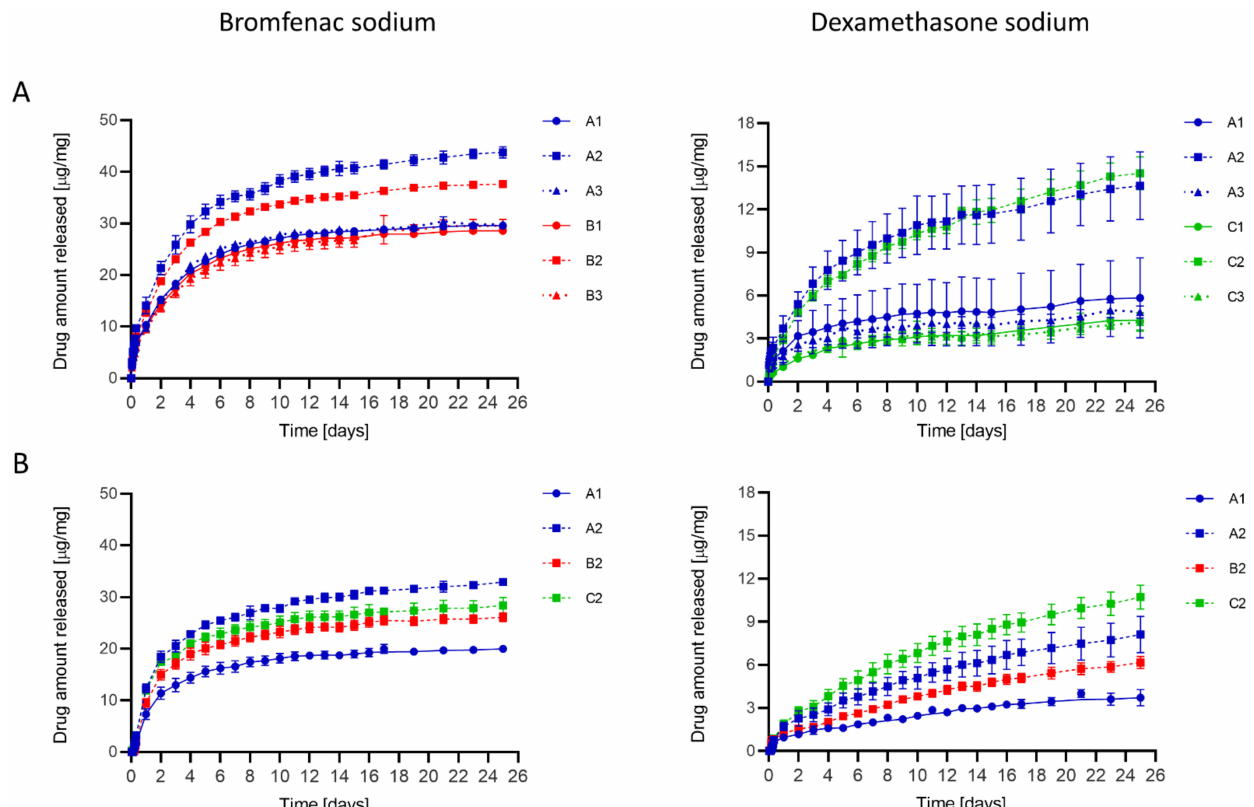
Figure 3. In vitro drug release from the hydrogel discs in 3 mL PBS, at 36 ◦ C and 180 rpm after individual drug loading ( A ) and dual-drug loading ( B ) by soaking in drug solutions for 1 week at 36 ◦